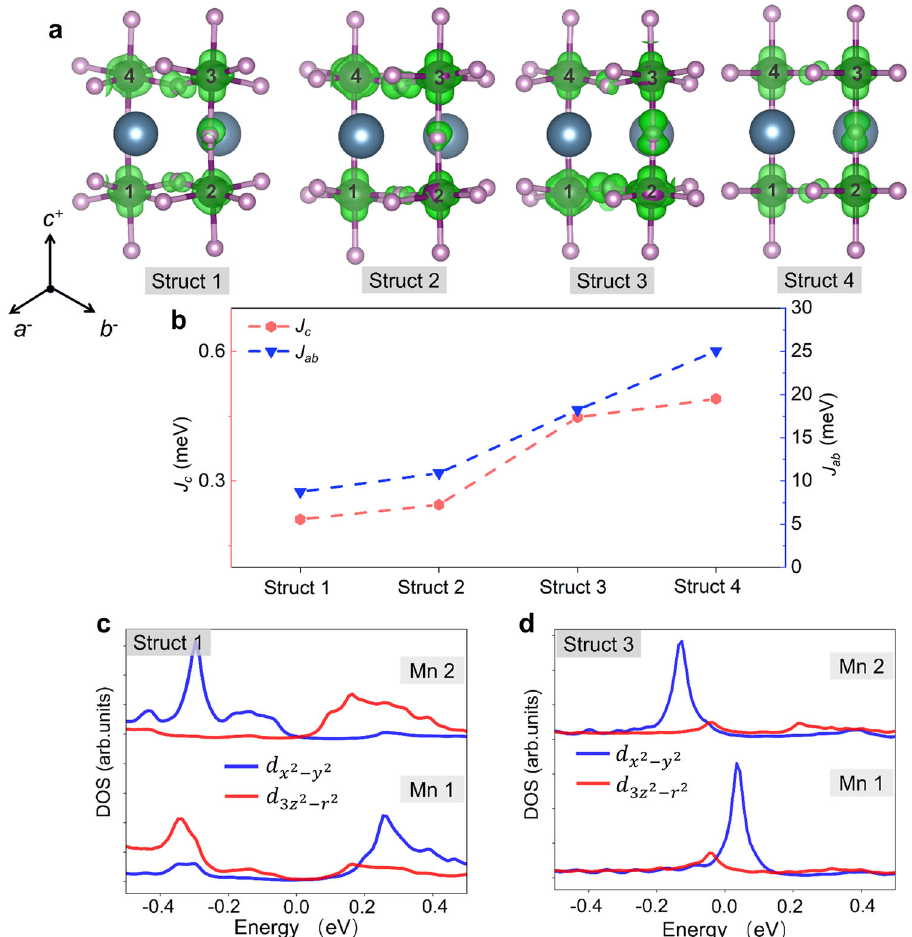
Fig. 4 The enhancement of ferromagnetism and metallicity by photo-induced structural changes. a The atomic structures (Struct 1 – 4) used in fi rst-principles calculations and their corresponding charge density distributions of orbitals near Fermi level. b The changes of magnetic exchange constants for the four structures used in the calculations. (Struct. 1 – Struct. 4). c , d the projected Density of States (DOS) for e g orbitals of the major spin of the two nearest Mn atoms (labeled as Mn 1 and Mn 2) in Struct 1 ( c ) and Struct 3 ( d ). Blue lines are projected DOS of d x 2 (cid:2) y 2 orbital, red lines are projected DOS of d 3 z 2 (cid:2) r 2